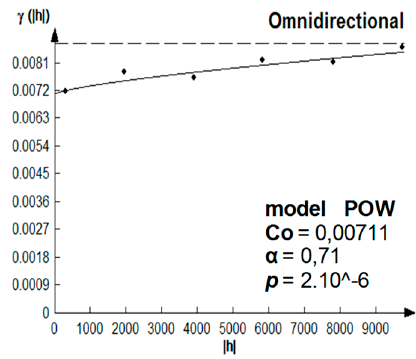
Figure B3. Omnidirectional and directional variogram—Belém urban zone. Figure A3. Omnidirectional and directional variogram—Bel é m urban zone.